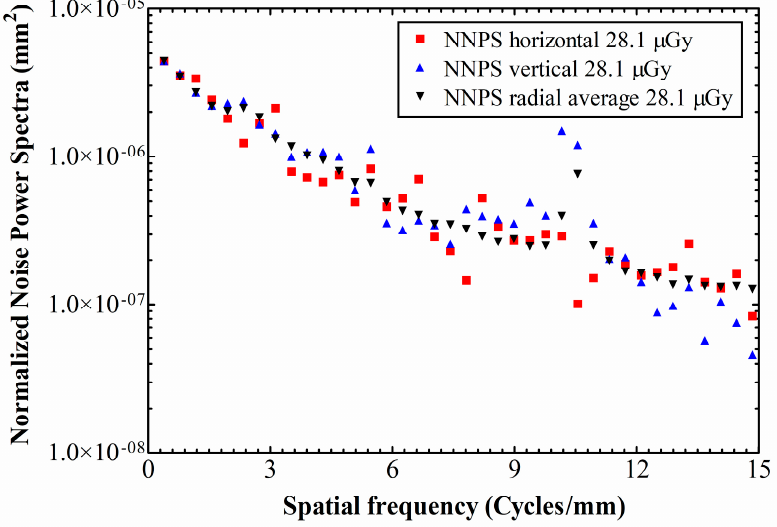
Figure 5. NNPS values at an exposure level of 28.1 μ Gy.